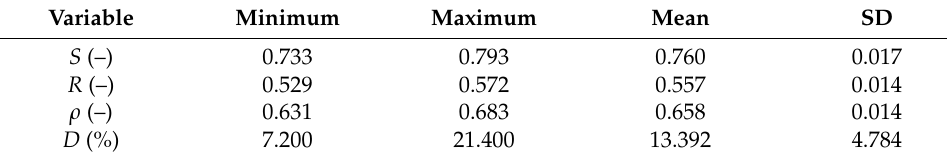
Table 2. Shape descriptors and damping ratio after 30 cyclic tests.